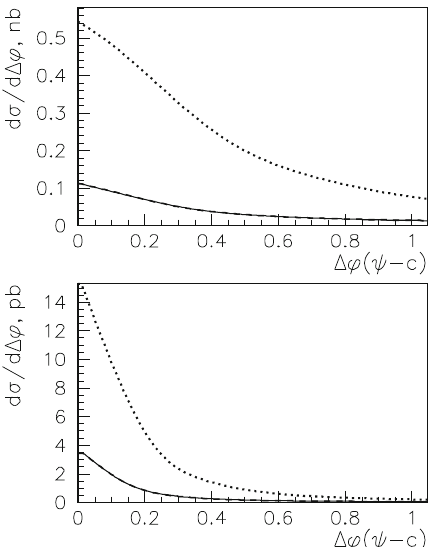
Fig. 5 Azimuthal angle difference between the partners in the J /ψ + c Fig. 4 Invariantmassofthe J /ψ + c systemasseenunderthedifferent system under the different kinematic selection rules. Upper panel: solid kinematic selection rules. Upper panel: solid curve, p ψ T > 20 GeV, > 20 GeV; dashed curve, p ψ > 20 GeV, > 20 GeV; dashed curve, p ψ > 20 GeV, p ∗ > 5 GeV; dotted curve, p ψ T > 20 GeV, p ∗ p ∗ T T T T T > 5 GeV; dotted curve, p ψ > 5 GeV, p ∗ > 20 GeV. Lower panel: > 20 GeV. Lower panel: solid curve, p ψ > p ∗ curve, p ψ T > 5 GeV, p ∗ T T T T T > 50 GeV; dashed curve, p ψ > 50 > 50 GeV; dashed curve, p ψ > 50 GeV, p ∗ > 20 GeV; solid curve, p ψ T > 50 GeV, p ∗ 50 GeV, p ∗ T T T T T > 20 GeV; dotted curve, p ψ > 20 GeV, p ∗ > 50 GeV > 50 GeV GeV, p ∗ dotted curve, p ψ T > 20 GeV, p ∗ T T T T